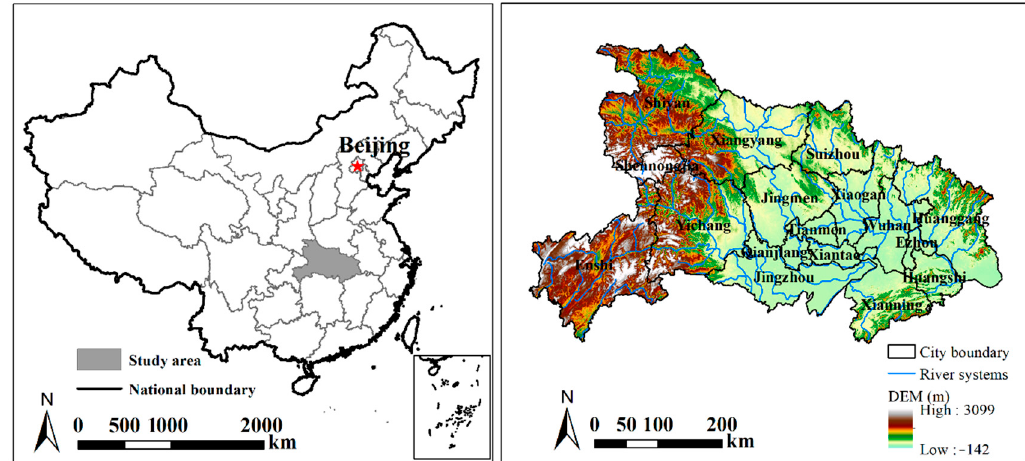
Figure 1. Location of Hubei Province.